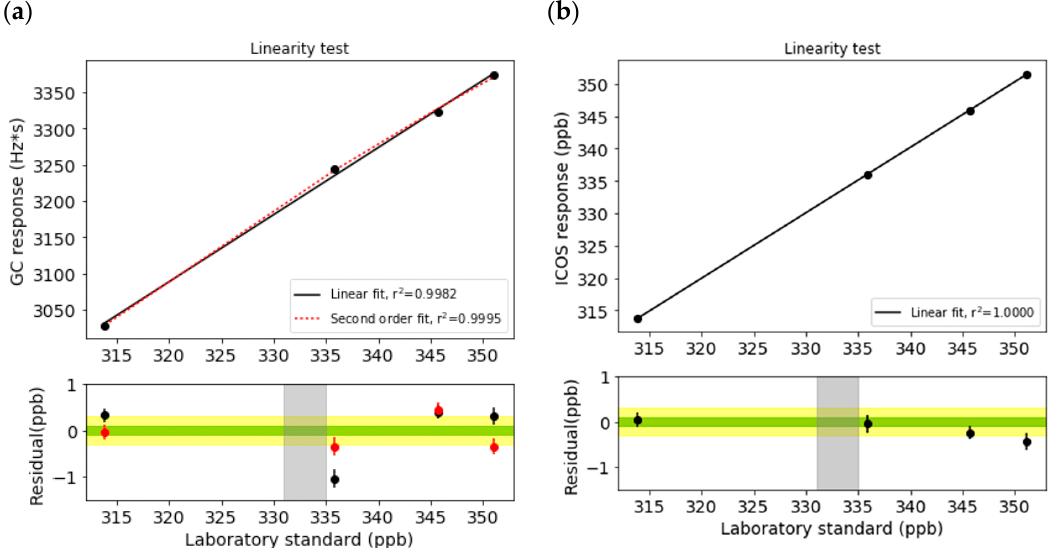
Figure 2. Linearity test of ( a ) the microelectron capture detector method (GC- µ ECD) and ( b ) o ff -axis integrated cavity output spectroscopy (OA-ICOS) for N 2 O. The x -axis is the assigned values of the laboratory standards, and the y -axis is the drift-corrected instrument response (top). Residuals are di ff erences, the laboratory standard minus the value from the regression (bottom). The black line and dots represent the linear regression function and residuals, respectively, while red represents a second-order polynomial and its residuals. For ( a ) GC- µ ECD, m is 9.2350 (r 2 = 0.9982), while it is 1.00116 for OA-ICOS (r 2 = 1) when the linear regression function is applied. The red lines and dots are derived from a second-order polynomial. The World Meteorological Organization / Global Atmosphere Watch Programme (WMO / GAW) compatibility goal ( ± 0.1 ppb) and extended compatibility goal ( ± 0.3 ppb) are shaded. The grey band represents the observed N 2 O level at JGS.